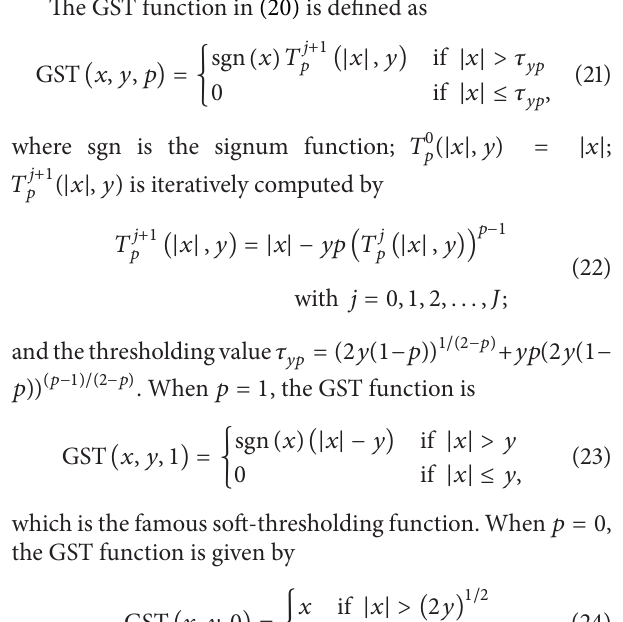
solution that is an approximation of the exact solution 𝑢 ∗